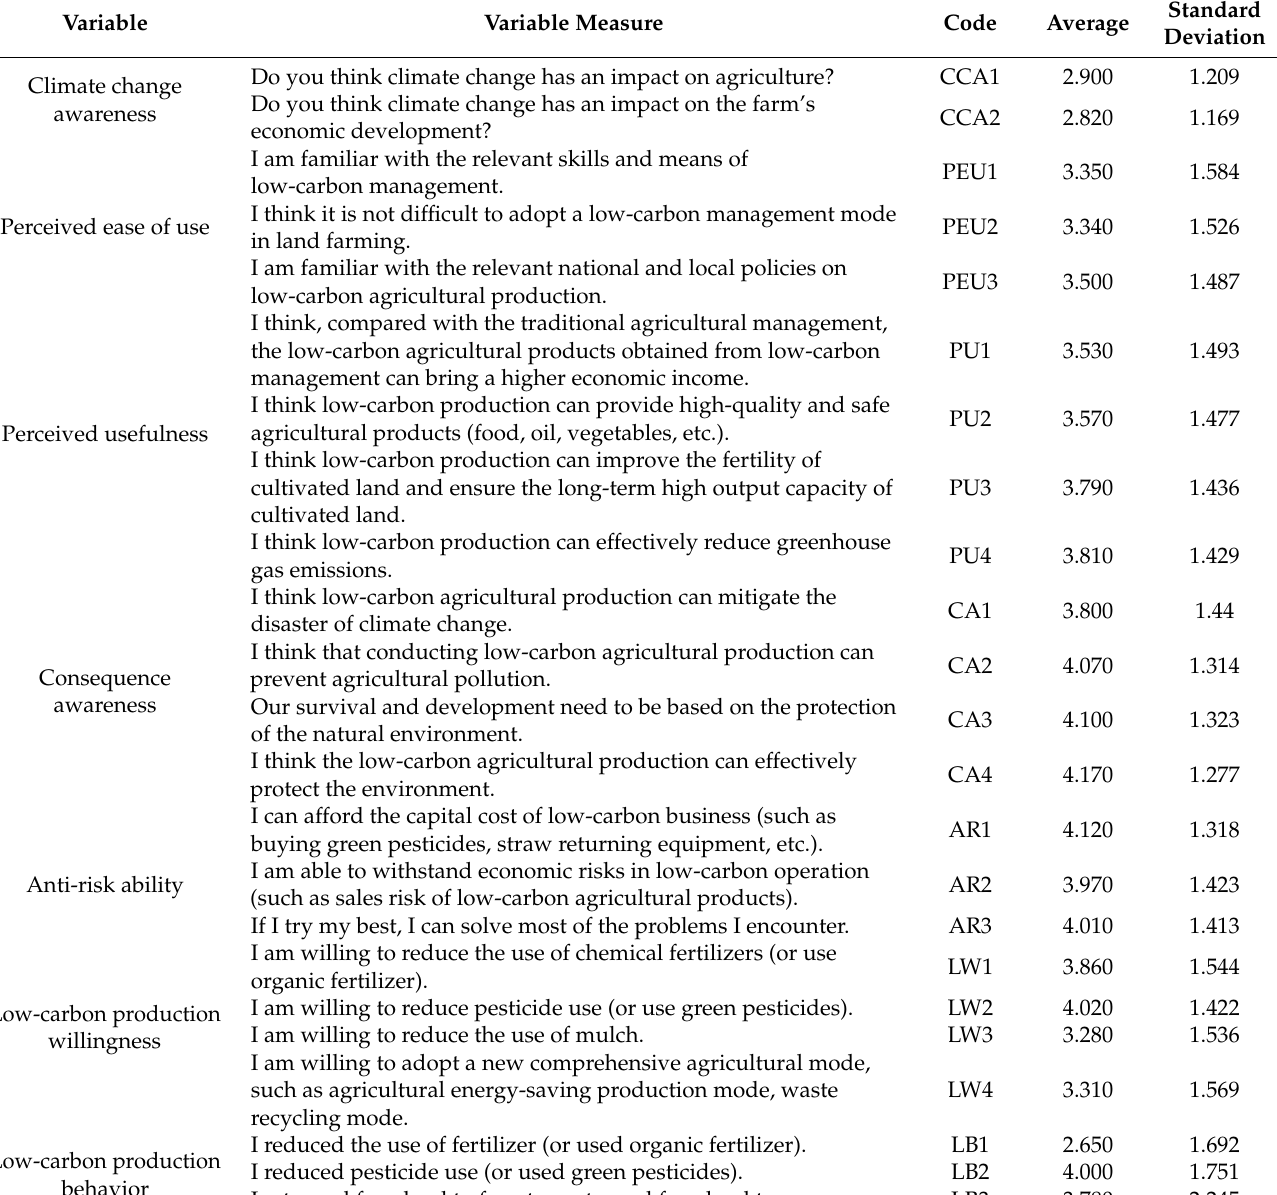
Table 2. Descriptive statistical analysis of the